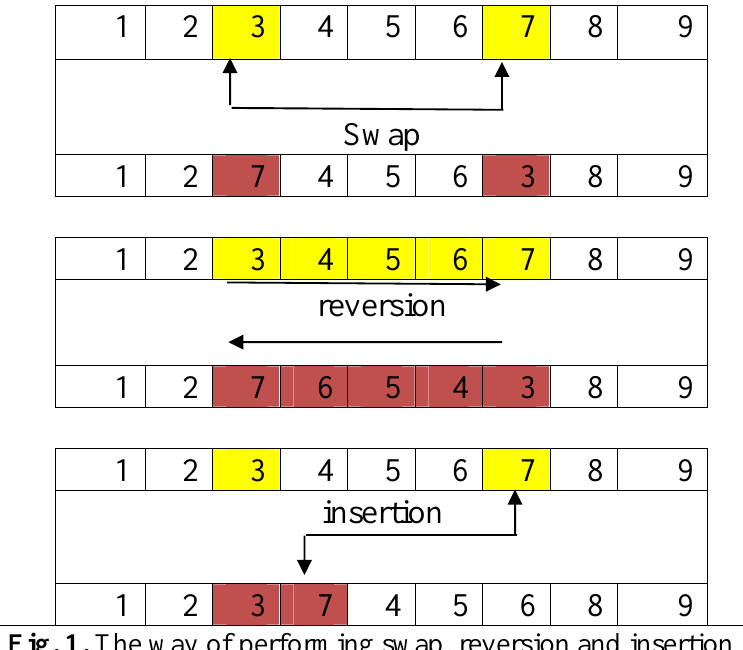
Fig. 1. The way of performing swap, reversion and insertion